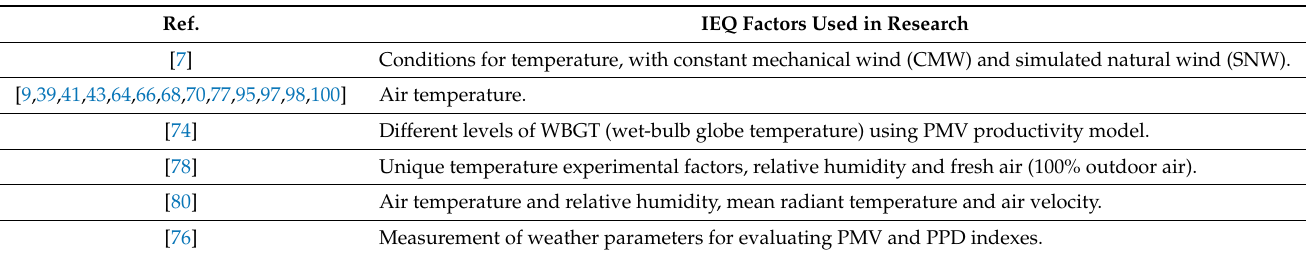
Table 5. Parameters used in